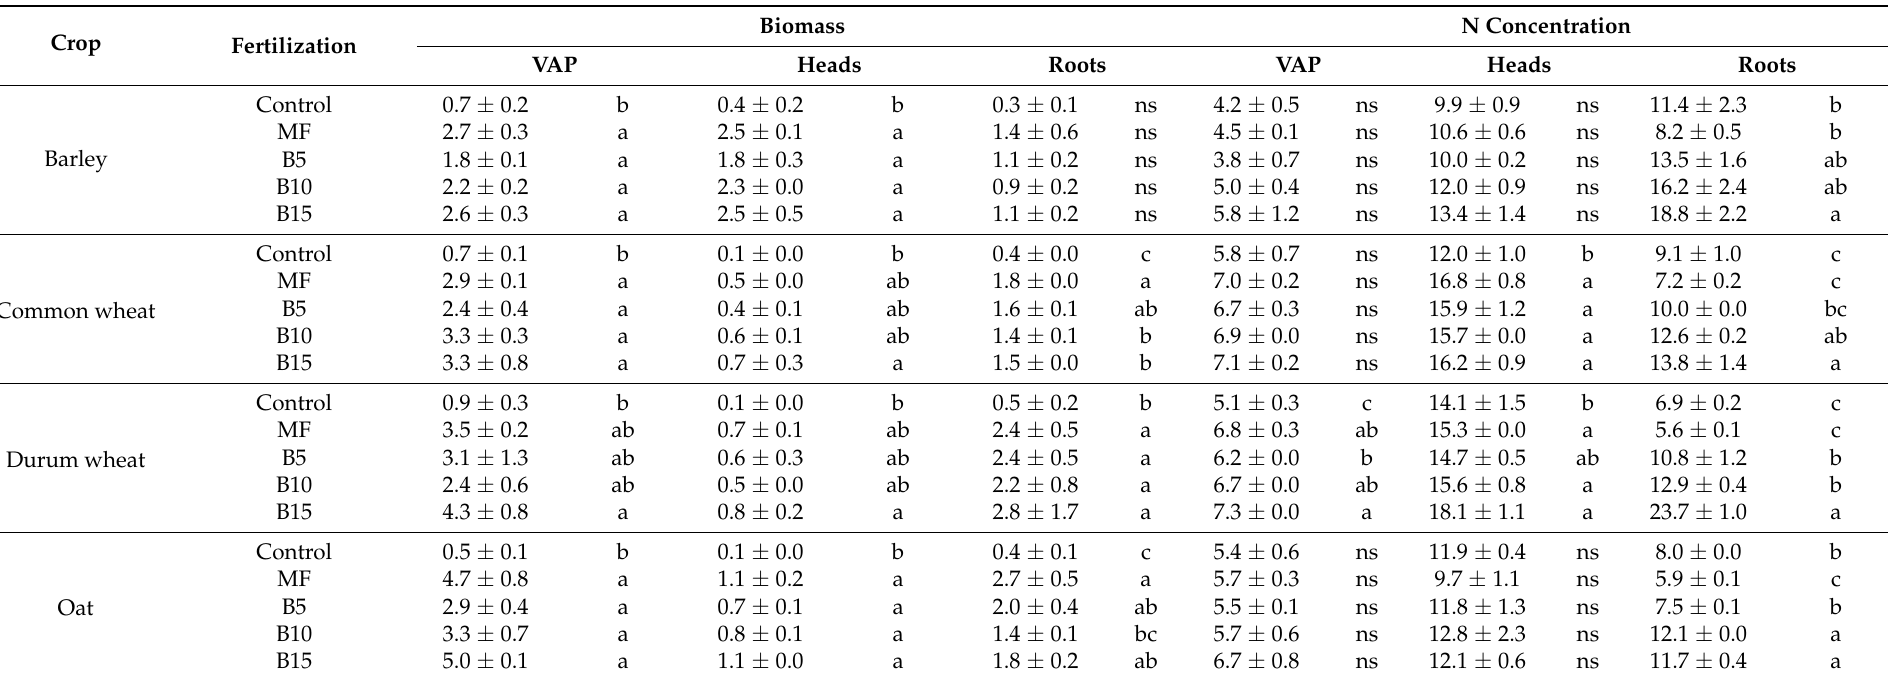
Table 3. Biomass (DW g plant − 1 ) and nitrogen concentration (g kg − 1 ) of vegetative aboveground plant parts, heads, and roots, as affected by fertilization treatment in barley, common wheat, durum wheat, and oat, at flowering (2017 season). Crop